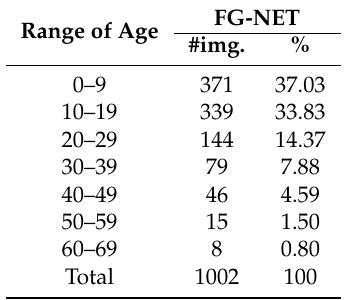
Table 4. FG-NET’s age level